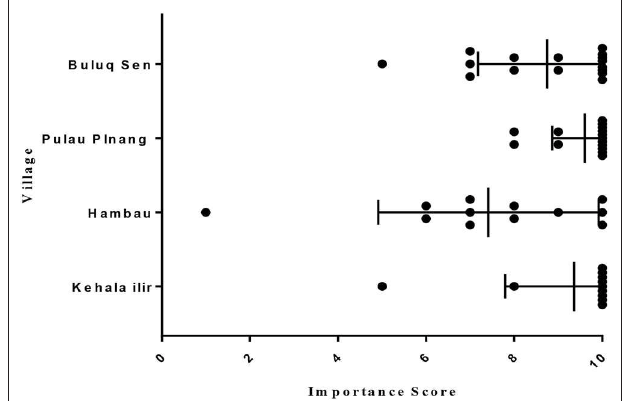
FIGURE 3 | Ecosystem Services importance values by village.